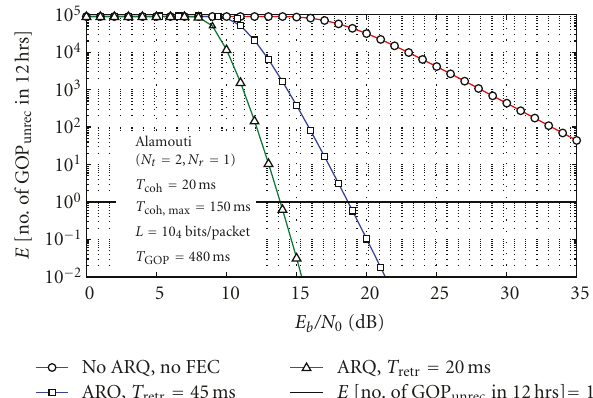
Figure 13: Average number of GOPs a ff ected by unrecoverable packet loss in 12 hours (Alamouti, N r = 1,